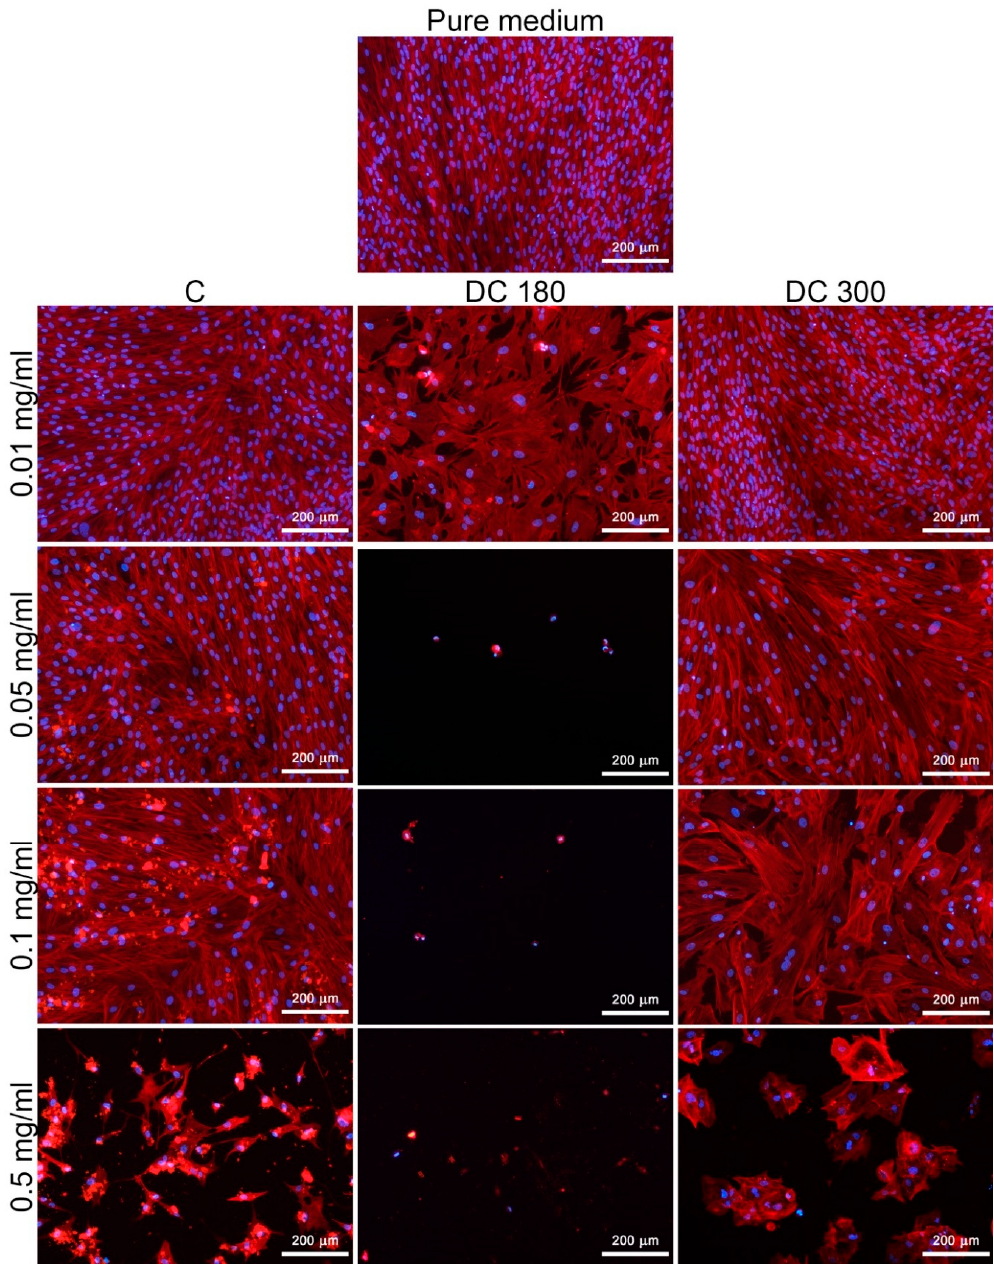
Figure 6. Morphology of human dermal fibroblasts cultivated in a pure cultivation medium and in media with unmodified curcumin (C), or with curcumin degraded at 180 °C (DC 180) or at 300 °C (DC 300) in various concentrations (0.01, 0.05, 0.1, and 0.5 mg/mL) on day 7 after adding the agent. The cells were stained with phalloidin-TRITC (red; F-actin cytoskeleton) and with DAPI (blue; cell nuclei). Olympus IX 51 microscope, obj. 10×, DP 70 digital camera.